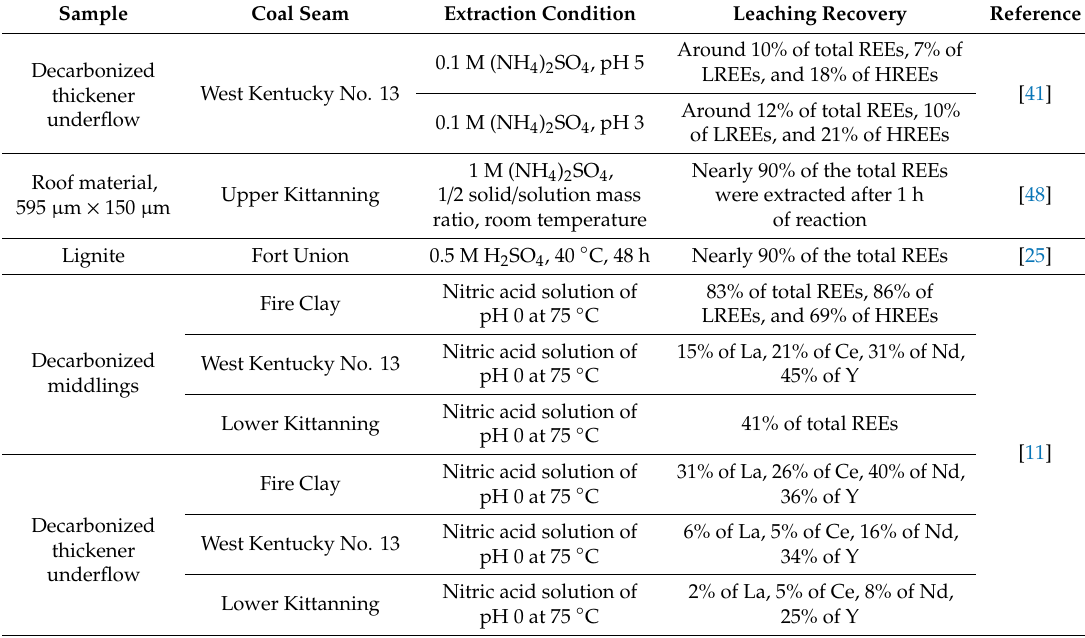
Table 2. A summary of salt and acid leaching of rare earth elements (REEs) from coal and coal